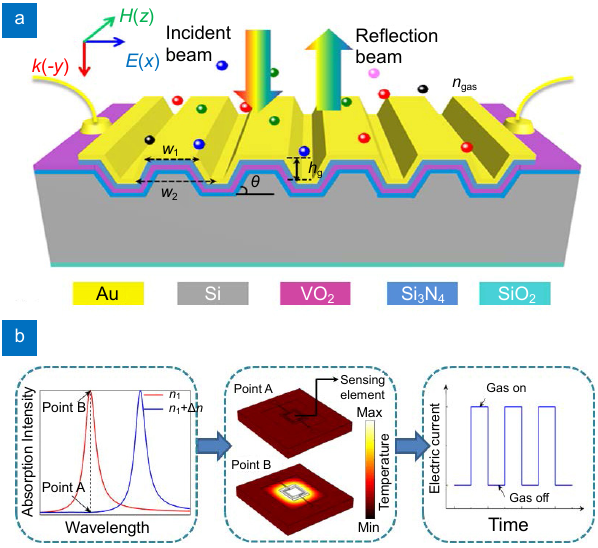
Fig. 1 | ( a ) Schematic of a multilayer stack (Au/Si 3 N 4 /VO 2 /Si 3 N 4 ) coated silicon gratings for on-chip gas sensing. ( b ) Sensing mecha- nism. The variation of gas concentration induces an in- crease/decrease of light absorbance of the microstructures and then causes a temperature increase/decrease, which generates an elec- trical signal via VO 2